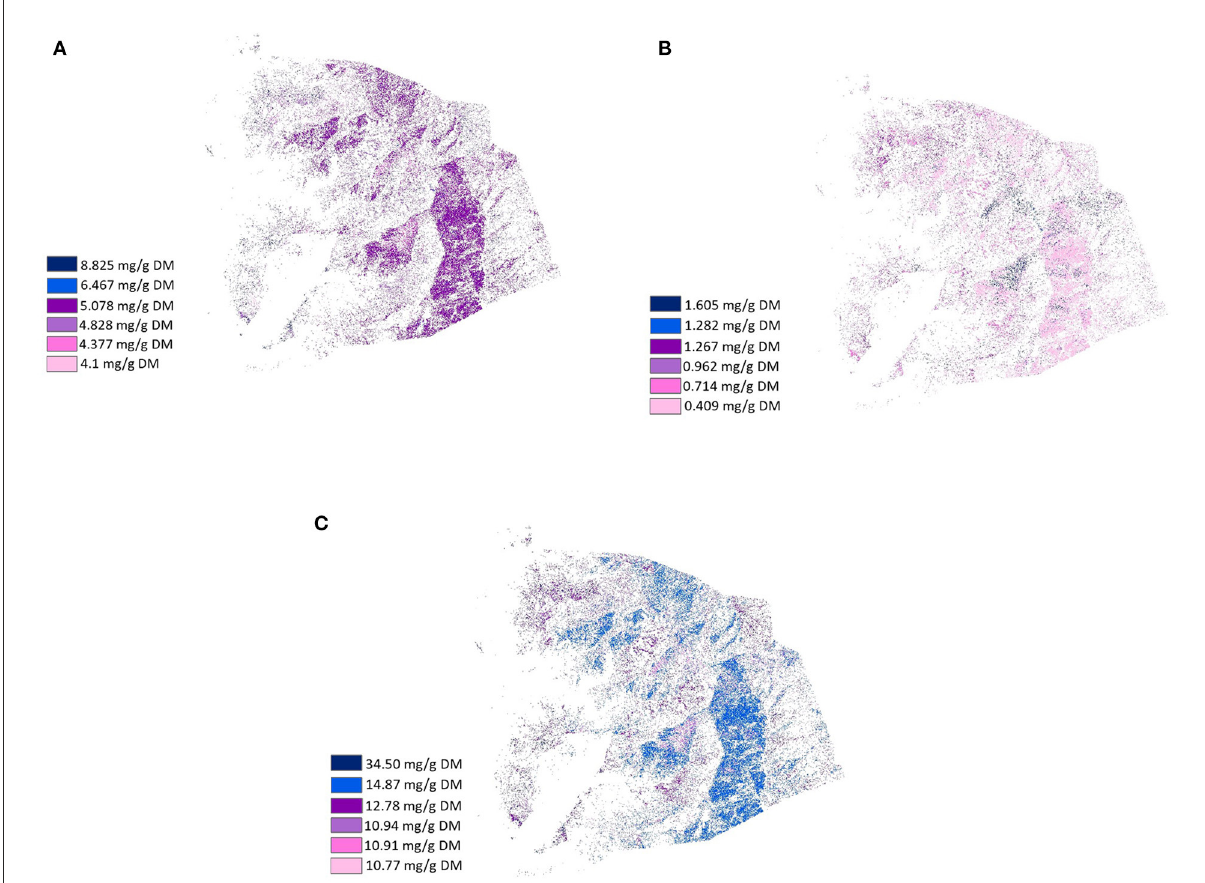
FIGURE6 Healthscape maps presenting the distribution and location of the variety of fatty acids saturation according to their concentration in plants (mg/g DM) from LUMGS (the Darkest color means the highest concentration). (A) Saturated, (B) Monounsaturated, and (C)